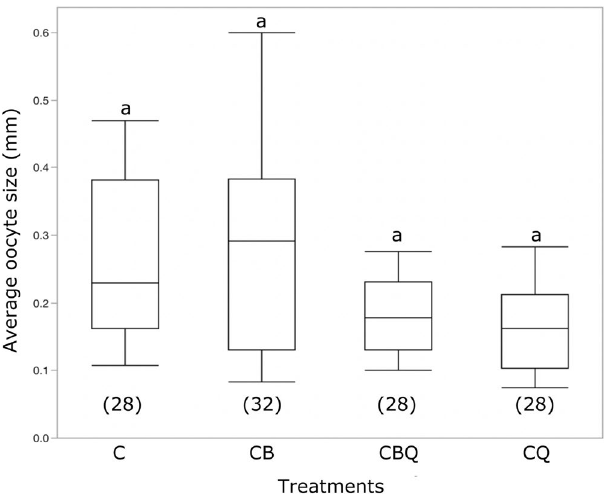
Figure 1. The effect of queen and brood presence on the average oocyte size of Bombus impatiens workers. Pair of newly emerged workers were assigned to four treatments and kept for three days with the queen (CQ), young brood (CB), the queen and young brood (CBQ), or alone (C). The numbers in parentheses denote the number of workers per treatment. Different letters above columns indicate statistical differences at α = 0.05.